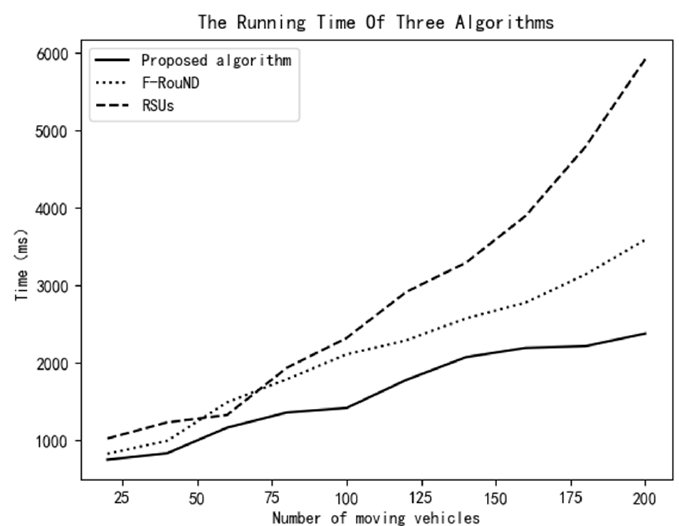
Figure 16. Variation of the running time vs. the number of moving vehicles.